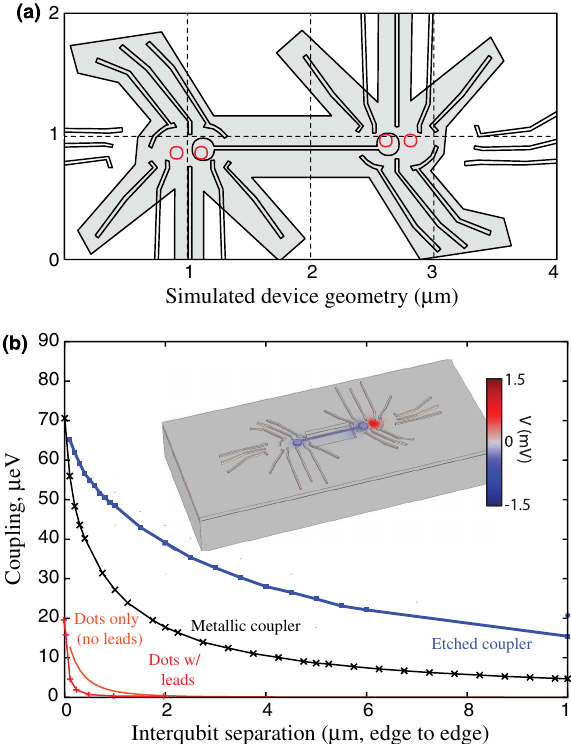
FIG. 6. Numeric simulation confirms the efficacy of the design for ST qubits; addition of a metallic coupler (crosses) increases coupling more than threefold for closely spaced dots, and greatly extends the range of the coupling. (a) The simulated device with a separation of 1 (cid:1) m and an etched coupler. 2DEG underneath the shaded region is treated as depleted, while red circles show the locations of the individual quantum dots within the simula- tion. (b) Coupling strength as a function of separation for the ST qubits in free space (smooth red curve, second from lower left), qubits including leads and 2DEG but without a coupler (red curve with þ signs in lower left corner), including a metallic coupler (curve with black crosses), and additionally etching a trench around the coupler to deplete the 2DEG underneath (curve with blue squares). Inset: Electrostatic potential (color scale) at the sample surface shows the impact of the coupler on a device with a 1 - (cid:1) m